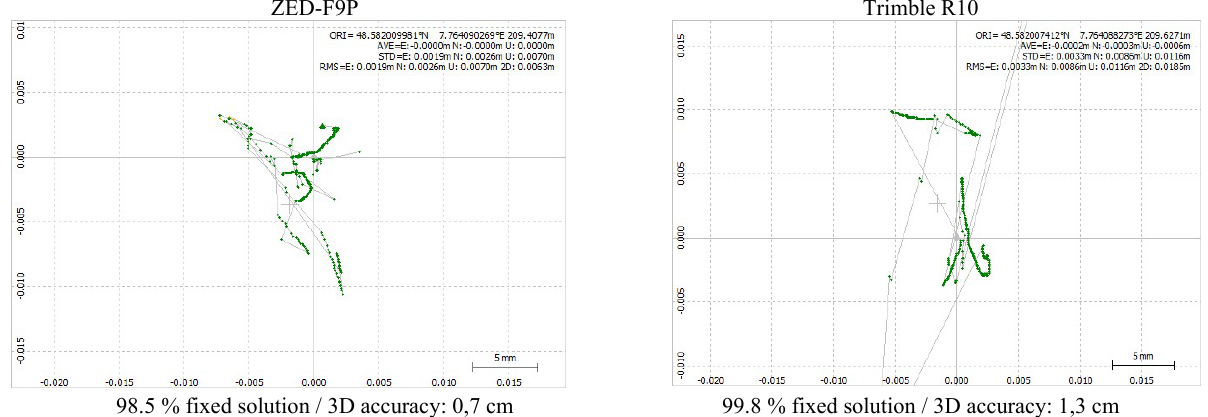
Figure 5 : Positioning result in post-treated RTK differential